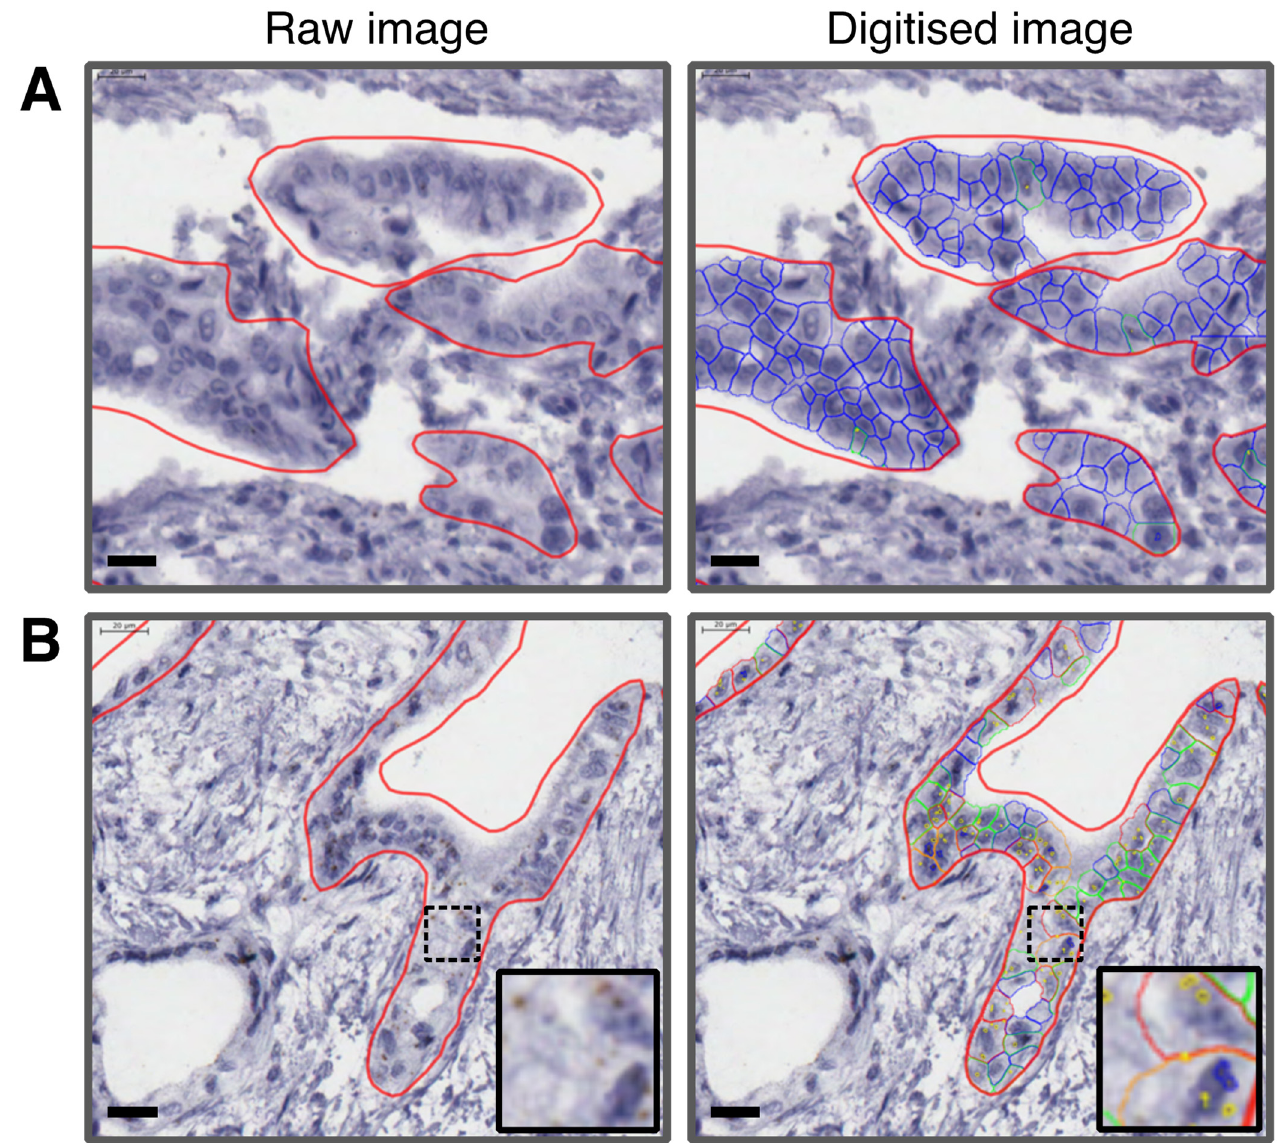
Figure 1. Representative images of tissue cores showing CDA mRNA expression before and after SpotStudio ® analysis. ( A ): Raw and digitized images of tissue expressing low CDA mRNA. ( B ): Raw and digitized images of tissue expressing high CDA, with inset example of cells with high CDA expression. Thick red line surrounds areas with tumor cells. Blue lines = Cells without any spots. Green lines = Cells with one single spot. Orange lines = Cells with between two and five spots. Thin red lines = Cells with six or more spots. Scale bar = 20 µm.